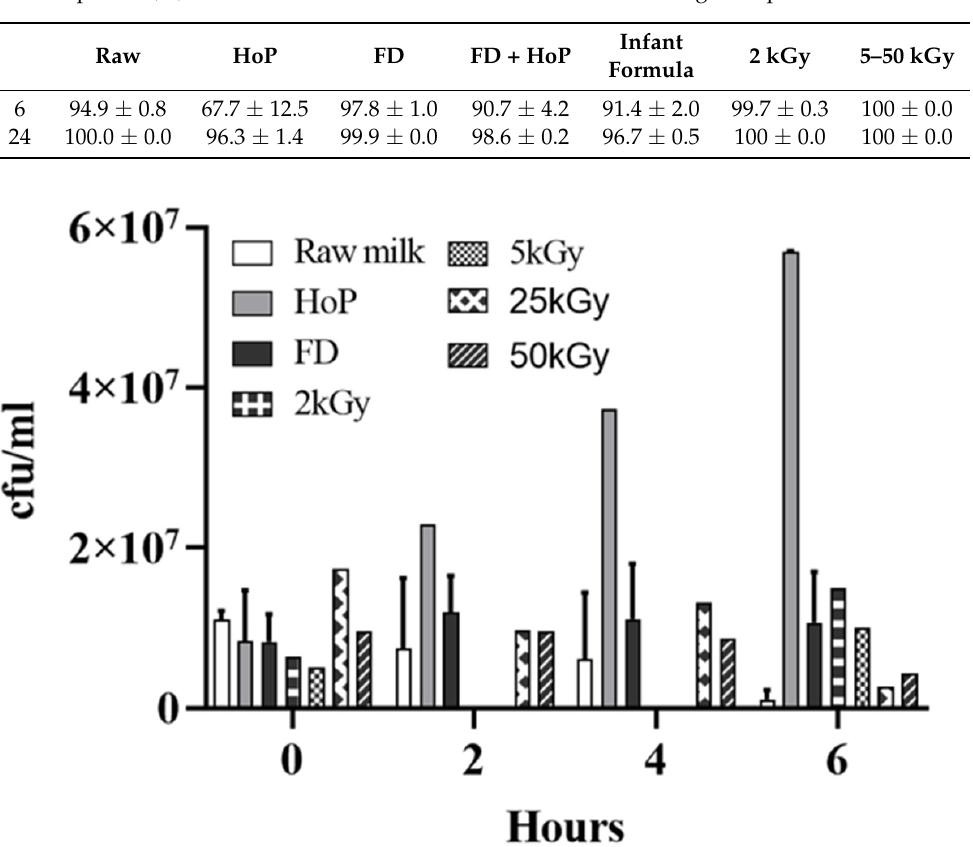
Figure 5. The comparison between the growth of S. aureus (inoculation dose 10 7 cfu/mL) in DHM processed by different methods after 6 h. Raw DHM was compared to Holder pasteurised DHM, FD-DHM and gamma-irradiated FD-DHM at 2 and 6 h for 2 and 5 kGy, and at 2, 4, and 6 h for 25 and 50 kGy. Values are the means ± SD of 2 biological replicates for raw milk, HoP and FD samples, and 2 technical replicates for 2, 5, 25, and 50 kGy